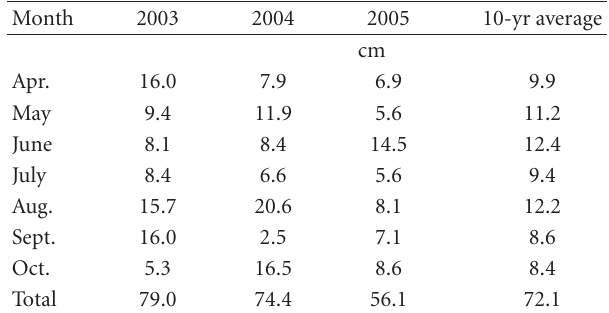
Table 6: Monthly and average rainfall during the soybean growing season from 2003 to 2005.